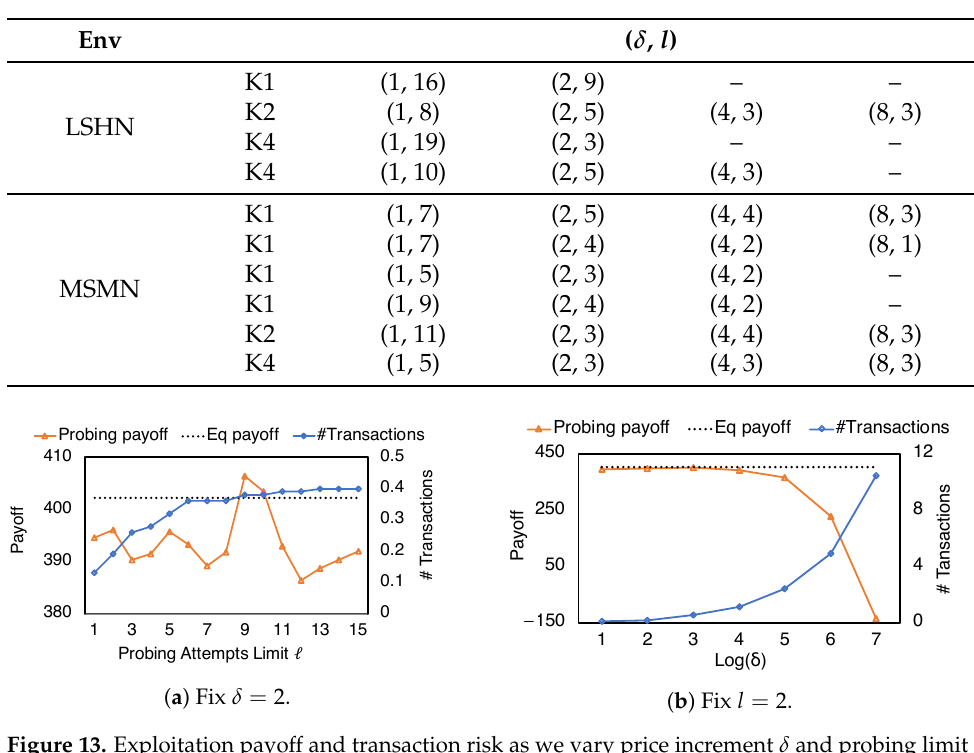
Table 3. Lowest number of probing attempts required to beat equilibrium performance.